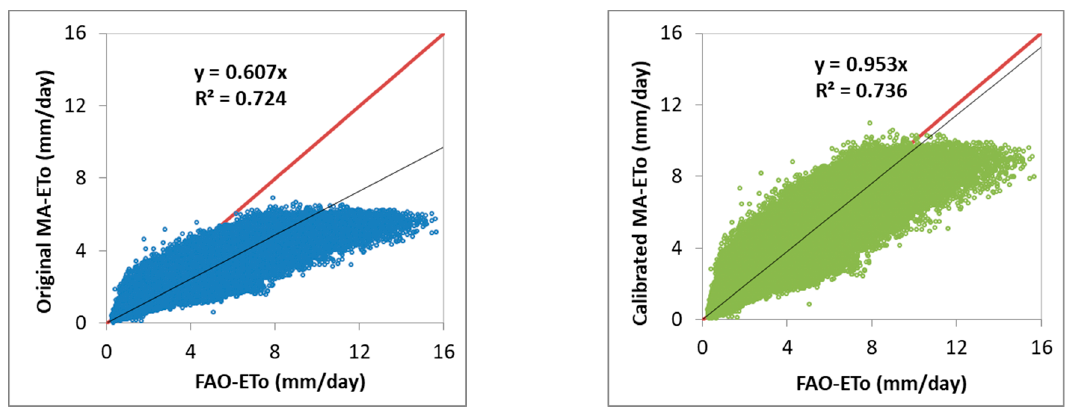
Figure 3. Relationship between estimated ET o by the selected empirical methods and FAO ‐ PM using WTM weather data.